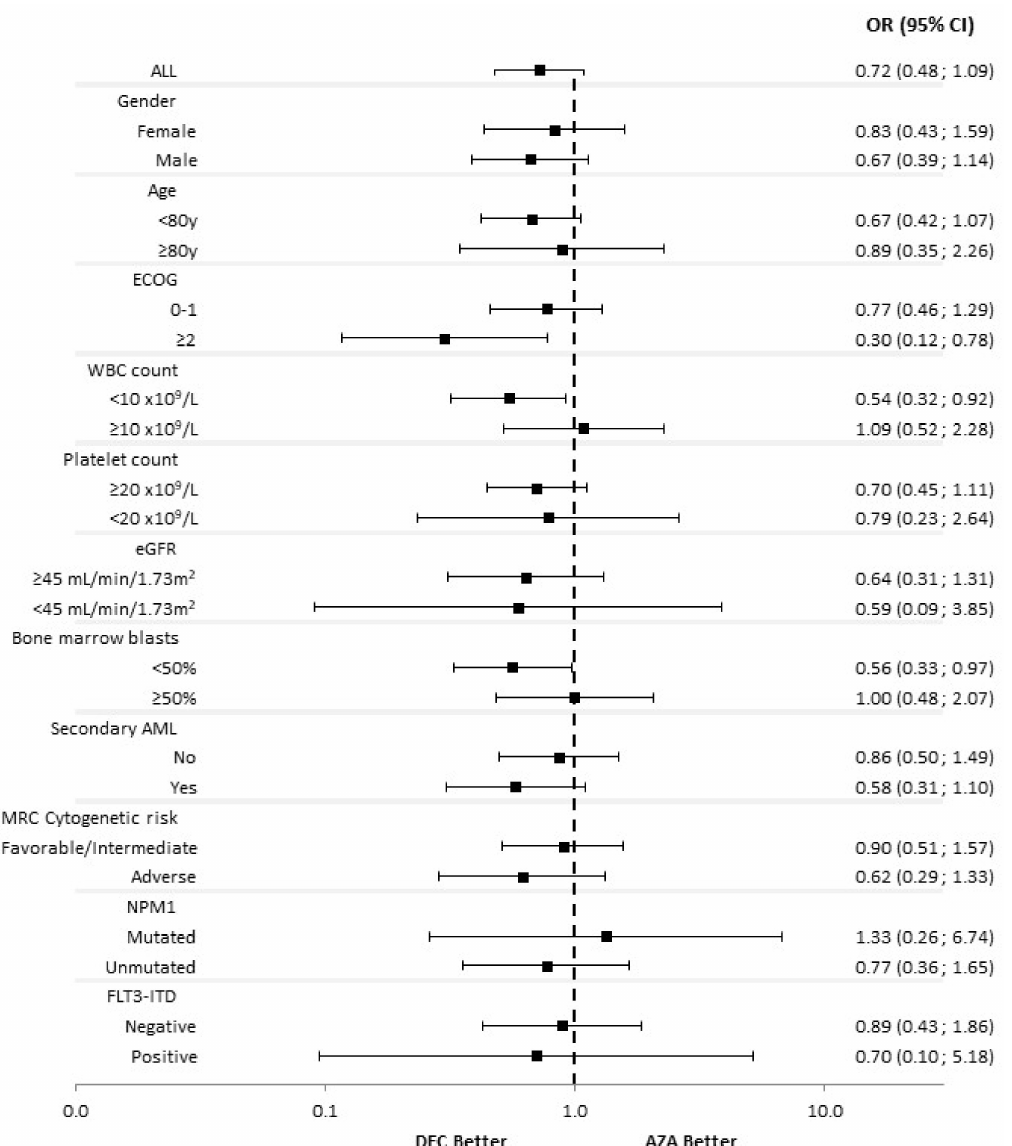
Figure 2. Subgroup analysis for ORR. AML, Acute myeloid leukemia; AZA, azacitidine; CR, complete remission; CRi, complete remission with incomplete blood count recovery; DEC, decitabine; ECOG, Eastern Cooperative Oncology Group; eGFR, estimated glomerular filtrate rate; FLT3, FMS-like tyrosine kinase 3; ITD: internal tandem duplication; MRC, Medical Research Council; NPM1, Nucleophosmin1; ORR, overall response rate (CR + CRi + PR); PR, partial remission; WBC, white blood